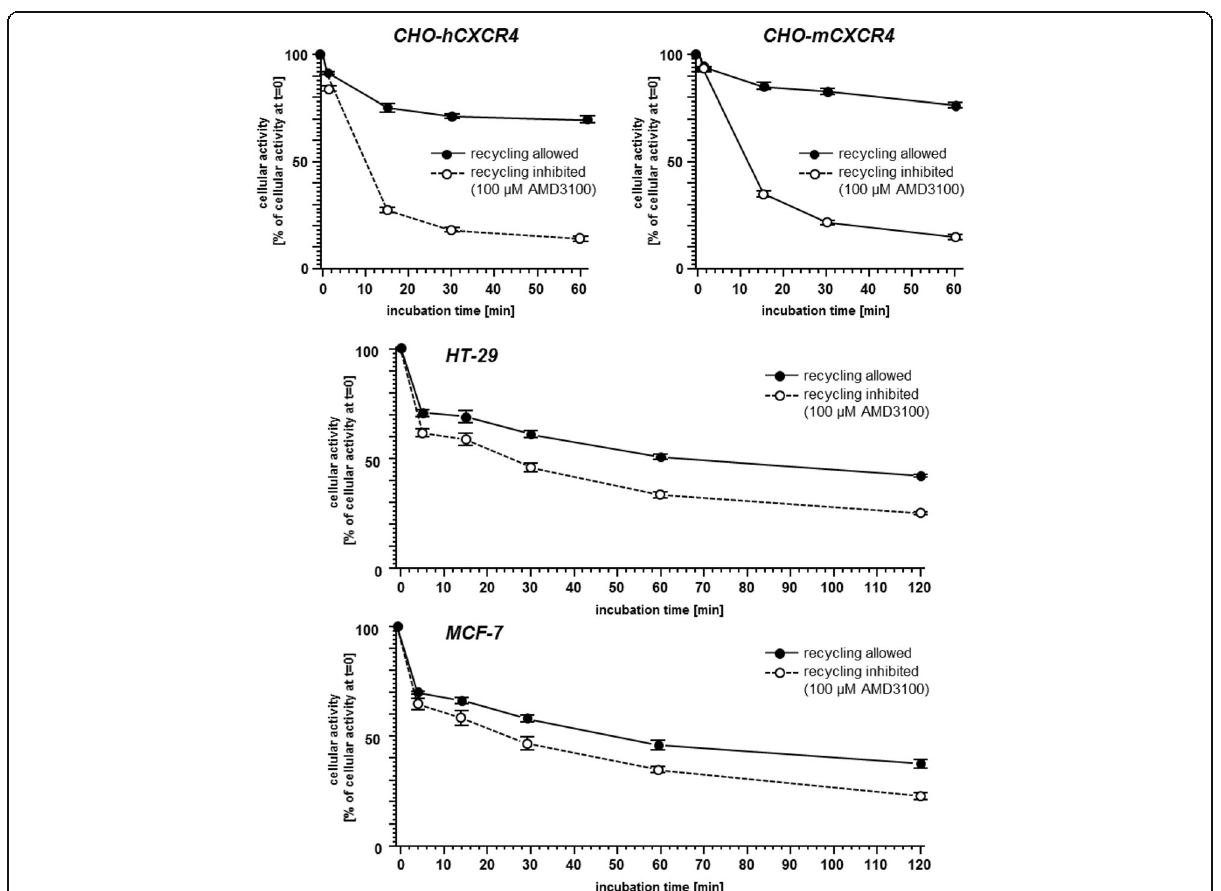
Fig. 3 Exemplary eternalization kinetics of [ 125 I]CPCR4.3 in different hCXCR4 (CHO-hCXCR4, HT-29, MCF-7) and mCXCR4 (CHO-mCXCR4) expressing cell lines. Externalization kinetics at 37 °C were determined under conditions allowing (assay medium only) or inhibiting (100 μ M AMD3100 in assay medium) ligand re-binding/recycling. Data are given as total cellular activity (% of cellular activity at t = 0). Each experiment was performed in triplicate, and results are means ± SD